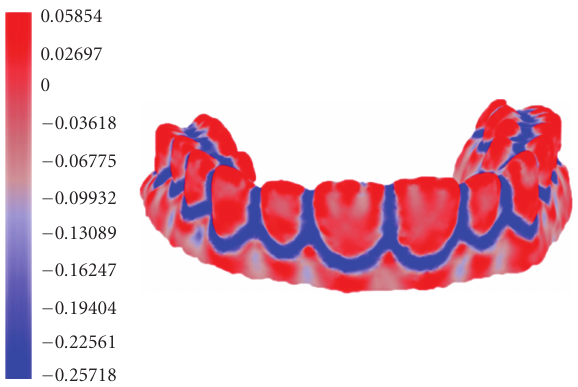
Figure 2: Minimum curvature color map of the 3D dental model